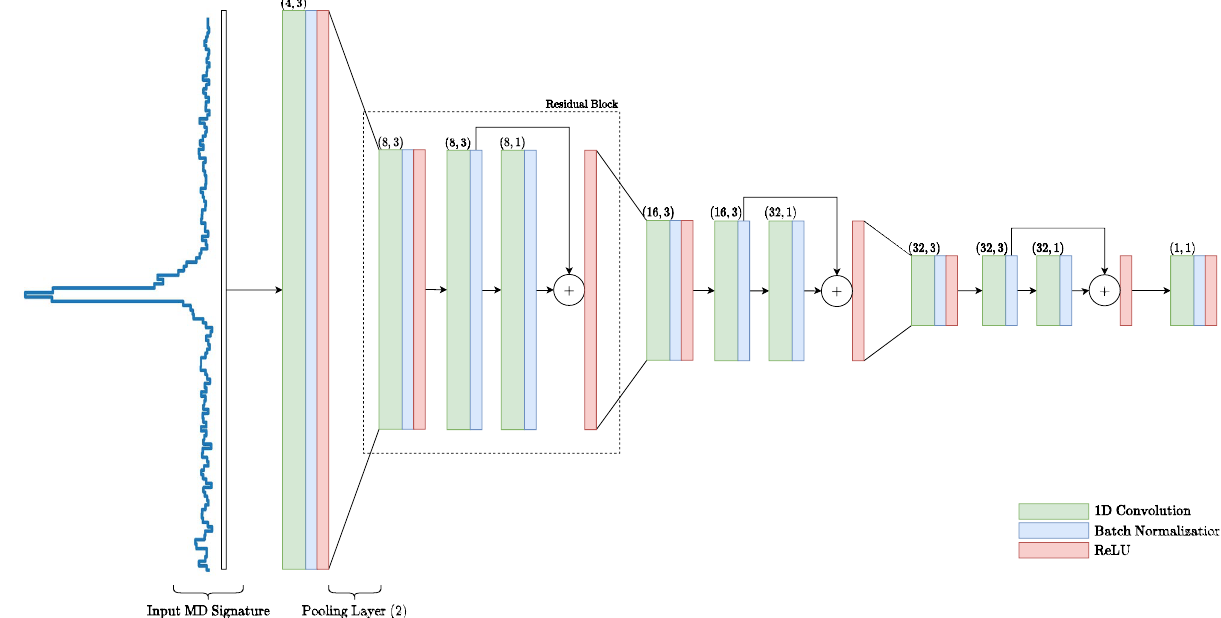
Figure 4. Full network structure of the 1-dimensional convolutional neural network for feature extraction. The input represents an MD signature when considering only a single step in time, noting that an MD signature is a distribution of velocities relative to the radar